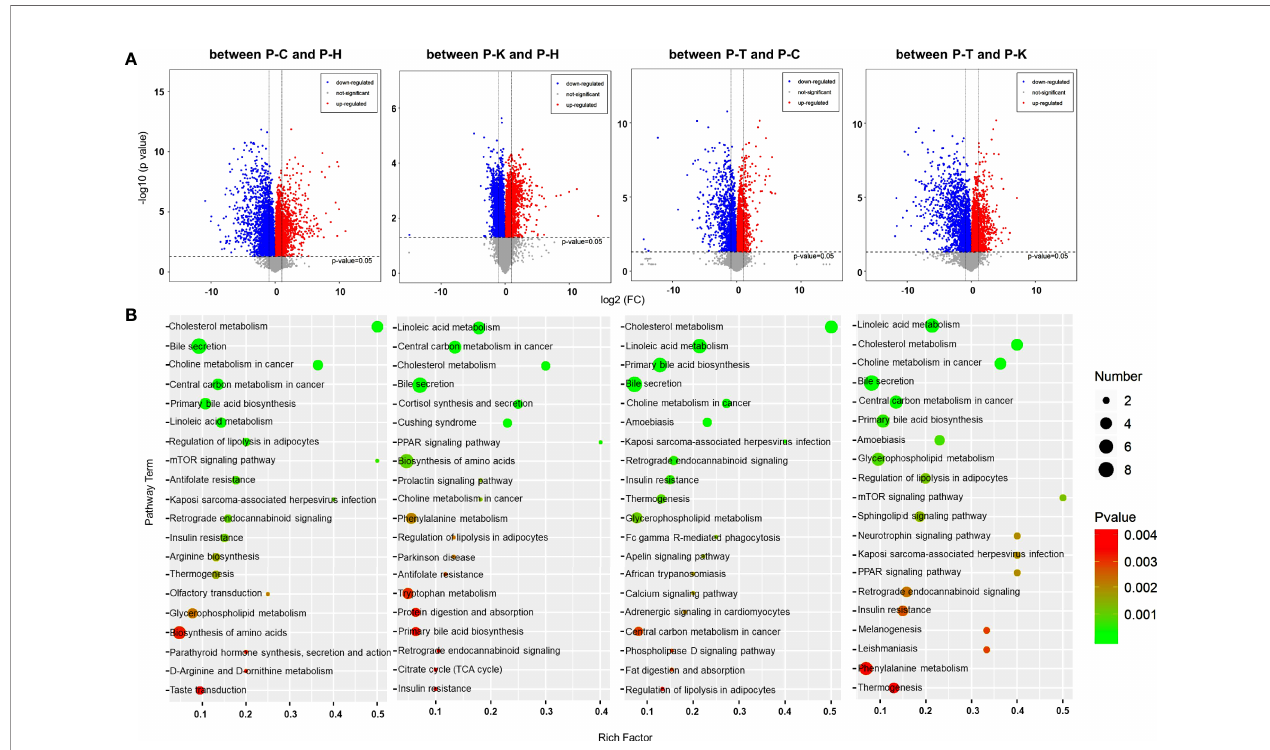
FIGURE 5 | Metabolomic analysis of the rat plasma. ( A) Volcano plots were prepared by plotting the log (base 2) of the FC and p values of t-test results (base 10) for differentially expressed plasma metabolites in rats between pairs of the four groups including healthy control (P-H) (n=6), CIA rats (P-C) (n=6), CIA rats treated with 2-DG (P-T) (n=6), and healthy rats treated with 2-DG (P-K). (B) The pathway analysis was performed based on the KEGG pathway database. The bubble chart shows the pathways that were enriched with DEMs in the plasma between pairs of the four